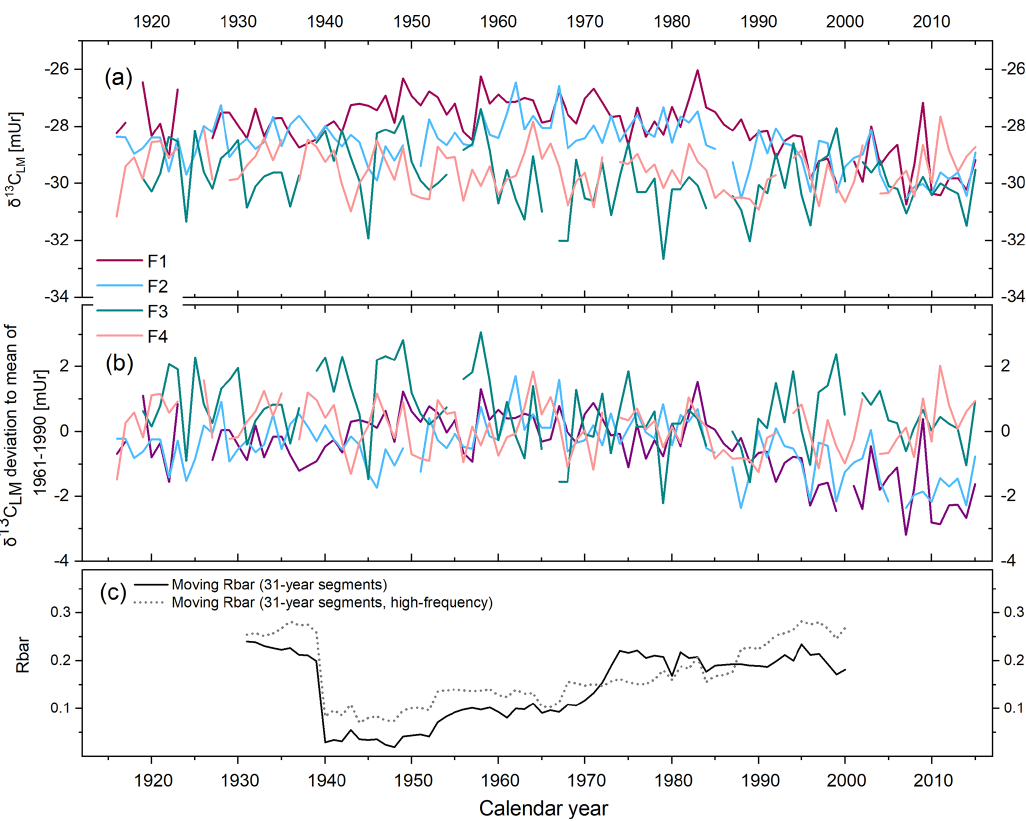
Figure 2. δ 13 C LM series of four Fagus sylvatica trees (F1–F4) from 1916–2015. (a) Annually resolved δ 13 C LM values. (b) δ 13 C LM anomalies shown as deviations from the 1961–1990 mean. (c) Moving Rbar of the δ 13 C LM_high-frequency (solid line) and the δ 13 C LM (dotted line) series.